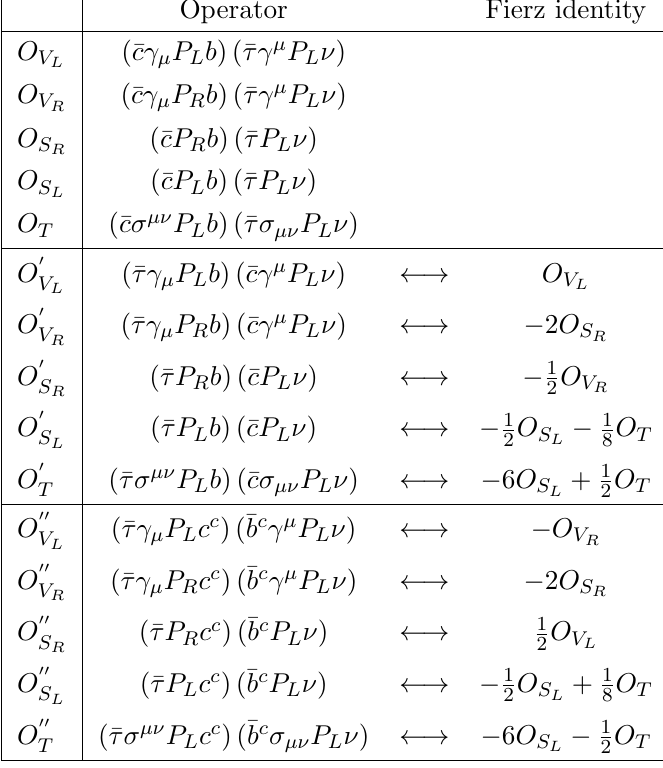
Table 1. All possible four-fermion operators that can contribute to b ! c(cid:28) (cid:22) (cid:23)